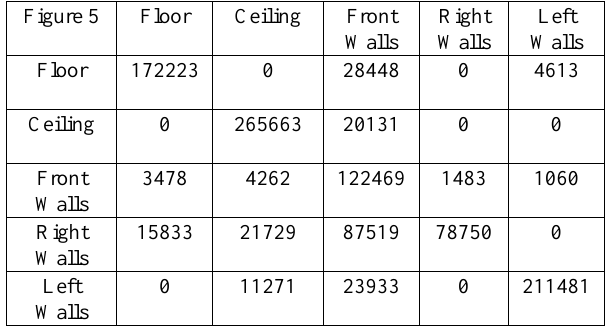
Table 1. Pixel to pixel correspondences based on